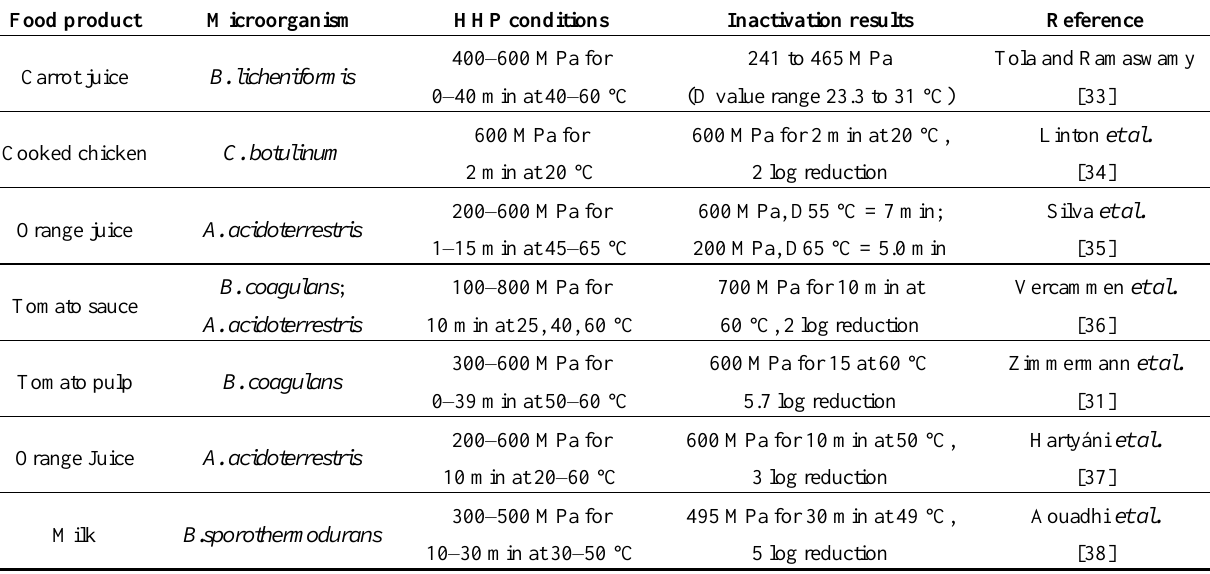
Table 3. HHP inactivation of spores in different